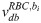
The relative velocity difference is smaller at divergent than at convergent capillary bifurcations.(A-B) Examples of an in vivo divergent (A) and convergent (B) capillary bifurcation. (C) Line scans for the divergent bifurcation in (A). (D) RBC velocity vdbRBC,bi in the daughter vessels of a divergent bifurcation in vivo. Dotted lines: median of each velocity. The velocity measurements have been performed consecutively (Methods). Further examples: S5 Fig. (E) Upper plot: Bulk flow velocity vdbbi in the daughter vessels of a divergent bifurcation for the simulation with red blood cells (RBCs, Methods). The time course has been smoothed by a moving average (Methods). Lower plot: Instantaneous relative velocity difference Δrvdb. Dotted lines: median of each variable. Blue box: |Δrvdb|≤20%, well-balanced flow situation. Further examples: S6 Fig. (F-J) Histogram: Distribution of the relative velocity difference at divergent |Δrvdb| (F, H, J) and convergent |Δrvcb| (G, I) capillary bifurcations for the simulation with RBCs (H, I) with passive particles, pPs (J) and in vivo (superscript: RBC; F, G). The histograms are normalized, i.e., the density of the underlying empirical distributions is displayed. Lower plot: Raw data for histograms. Blue bars: Well-balanced bifurcations (|Δrvdb|≤20%). DoWB: Degree of well-balanced bifurcations: ratio of the number of well-balanced bifurcations to the total number of bifurcations (n). A detailed analysis of the distributions is provided in the Methods. (K) Cumulative density of |Δrv| for the simulation with RBCs and the in vivo measurements. Filling indicates regions where the cumulative density of divergent bifurcations is larger than that of convergent ones. For all in vivo measurements (D, F-G, K) the RBC velocity is displayed instead of the bulk flow velocity (superscript: RBC). Mouse icon: in vivo measurements. Computer icon: simulation results.